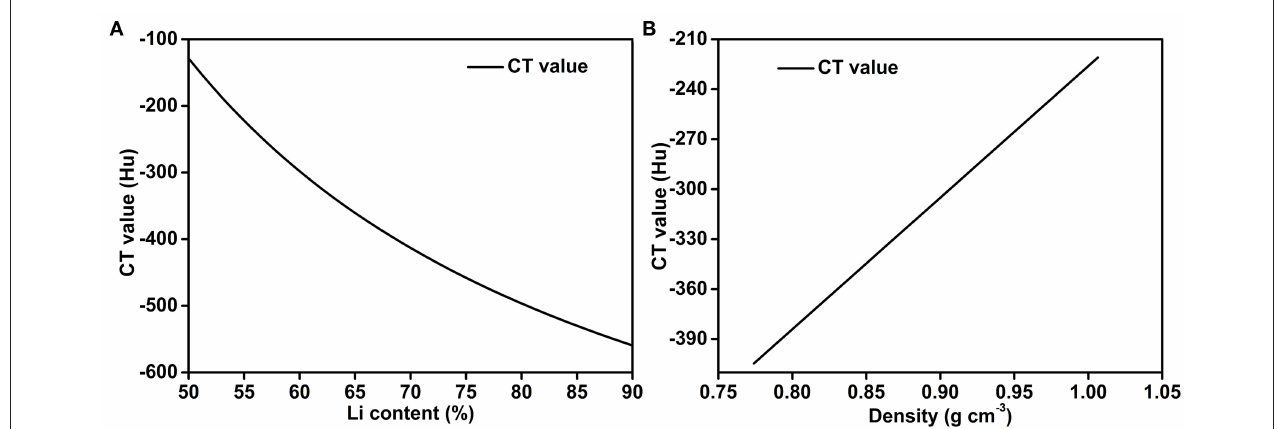
FIGURE 6 | Quantitative relationships for (A) the CT value and Li wt.%, and (B) the CT value and the density of the Li-B alloy.